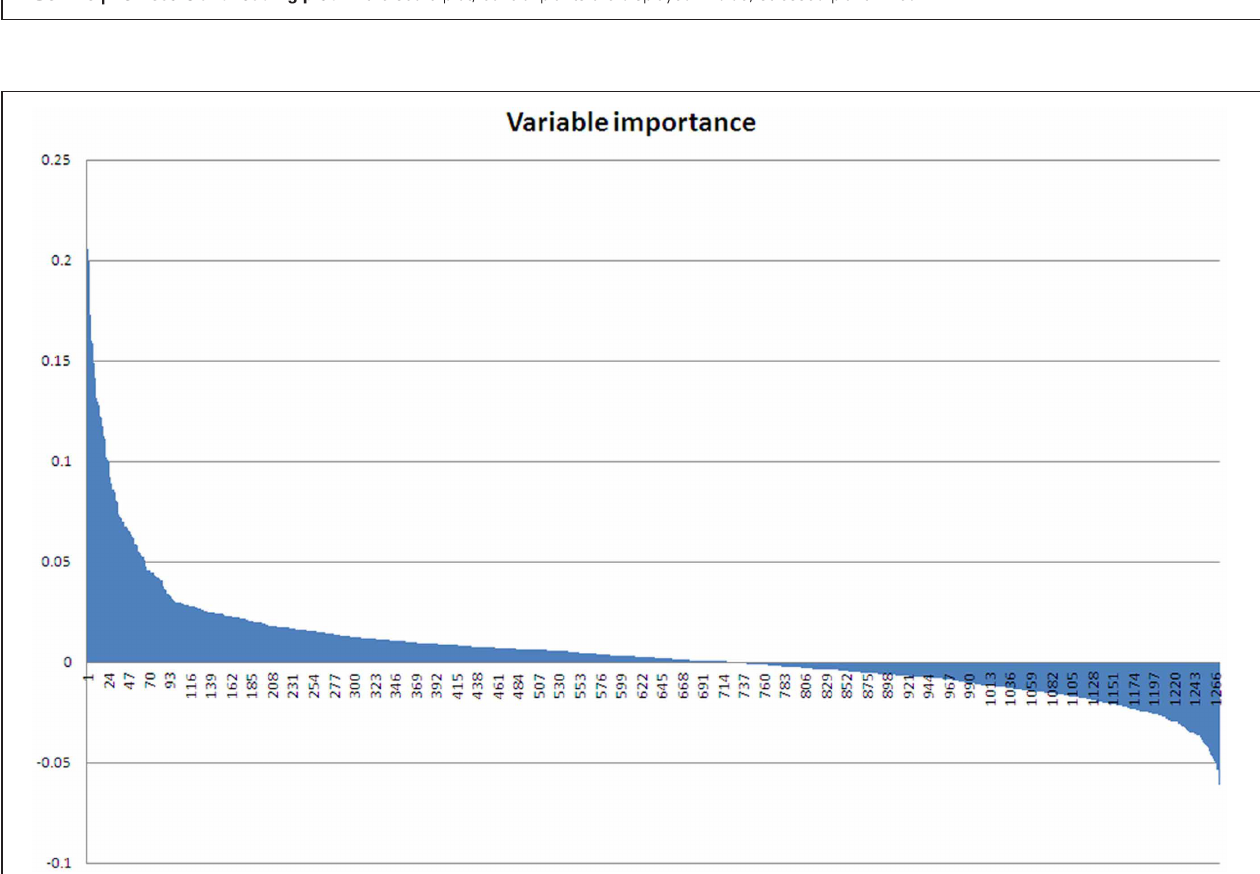
FIGURE 3 | PCA score and loading plot. In the score plot, control plants are displayed in blue, stressed plant in red.